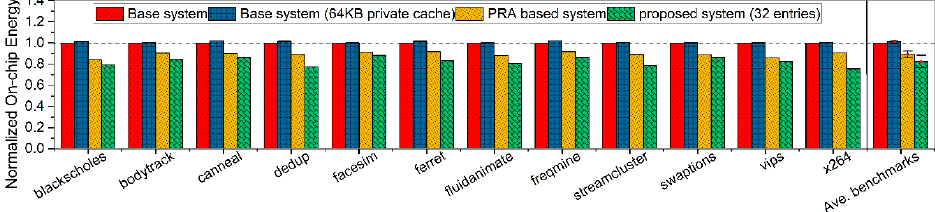
Figure 13. Normalized on-chip energy comparisons among four methods, while our proposed system is allocated with 32 history buffer entries.